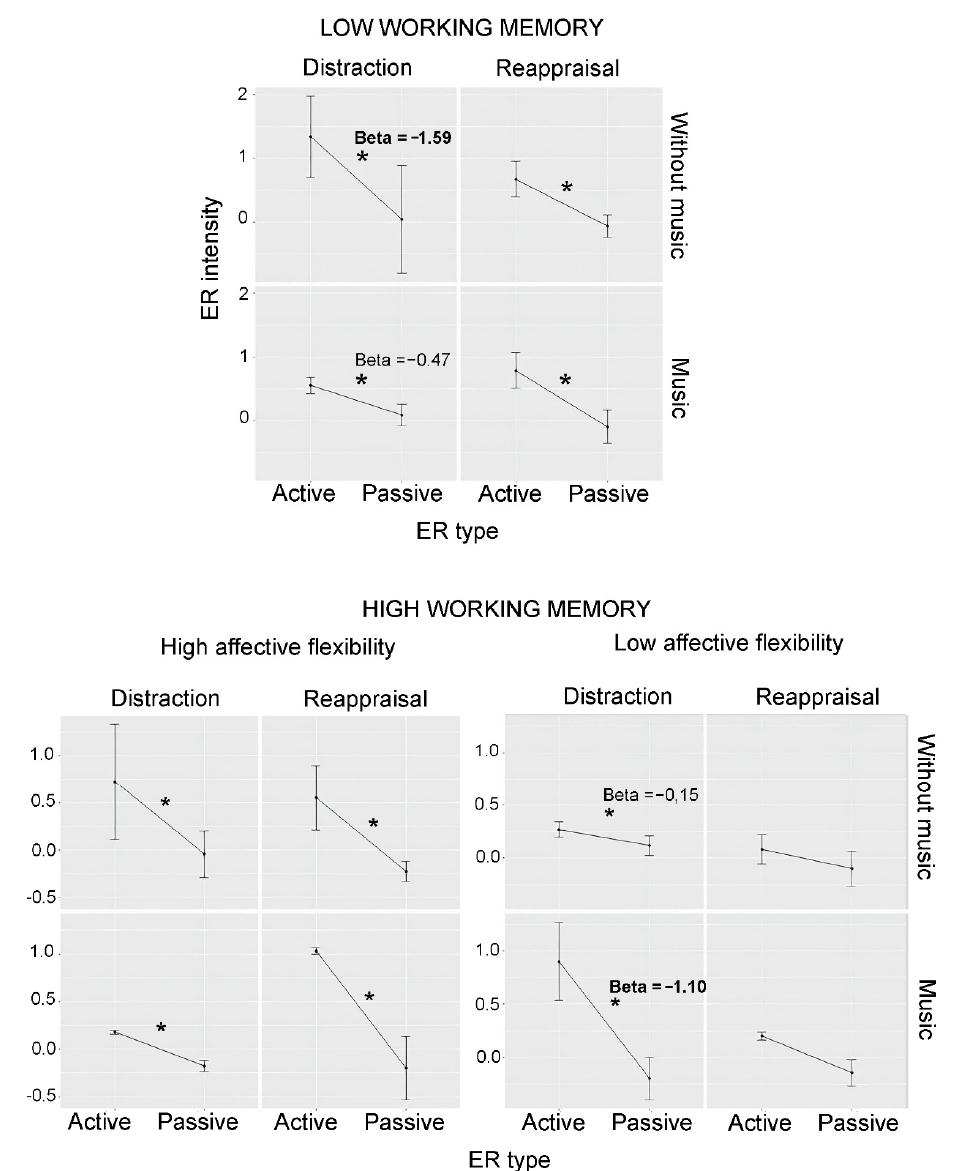
Figure 3. ER intensity according to ER type, music, and strategy (distraction vs. reappraisal) for low- vs. high-working-memory participants and, within the latter, for participants with high vs. low affective flexibility. In low-working-memory participants, distraction was decreased by music. In high-working-memory participants with low affective flexibility, distraction benefited from music. Asterisks indicate significant effects.